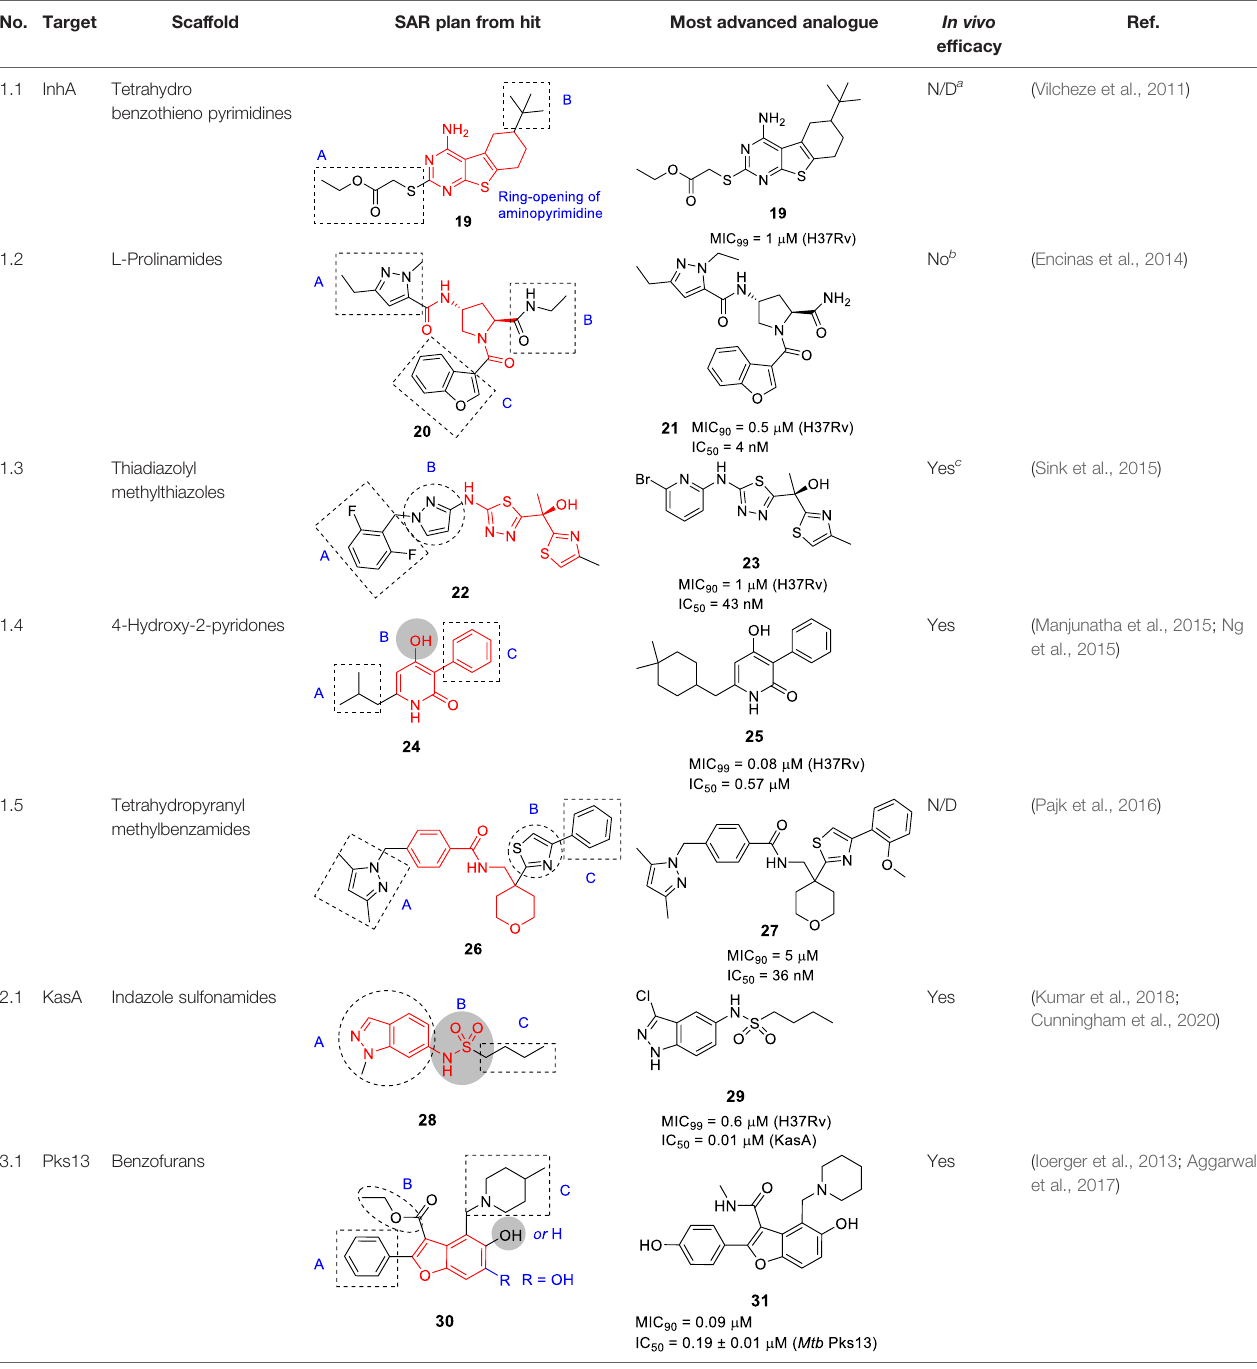
TABLE 2 | Antitubercular agents inhibiting mycolic acid biosynthesis. No.